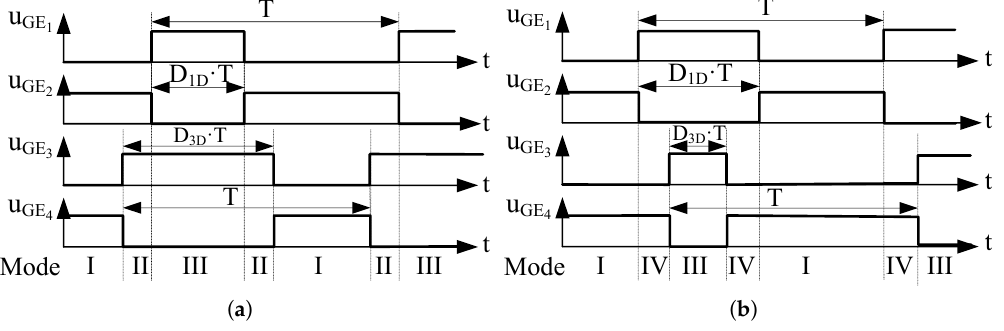
Figure 5. Switching modes in the SPC for the pulse scheme considered: ( a ) D 3 and ( b ) D 3 is smaller than D 1 D